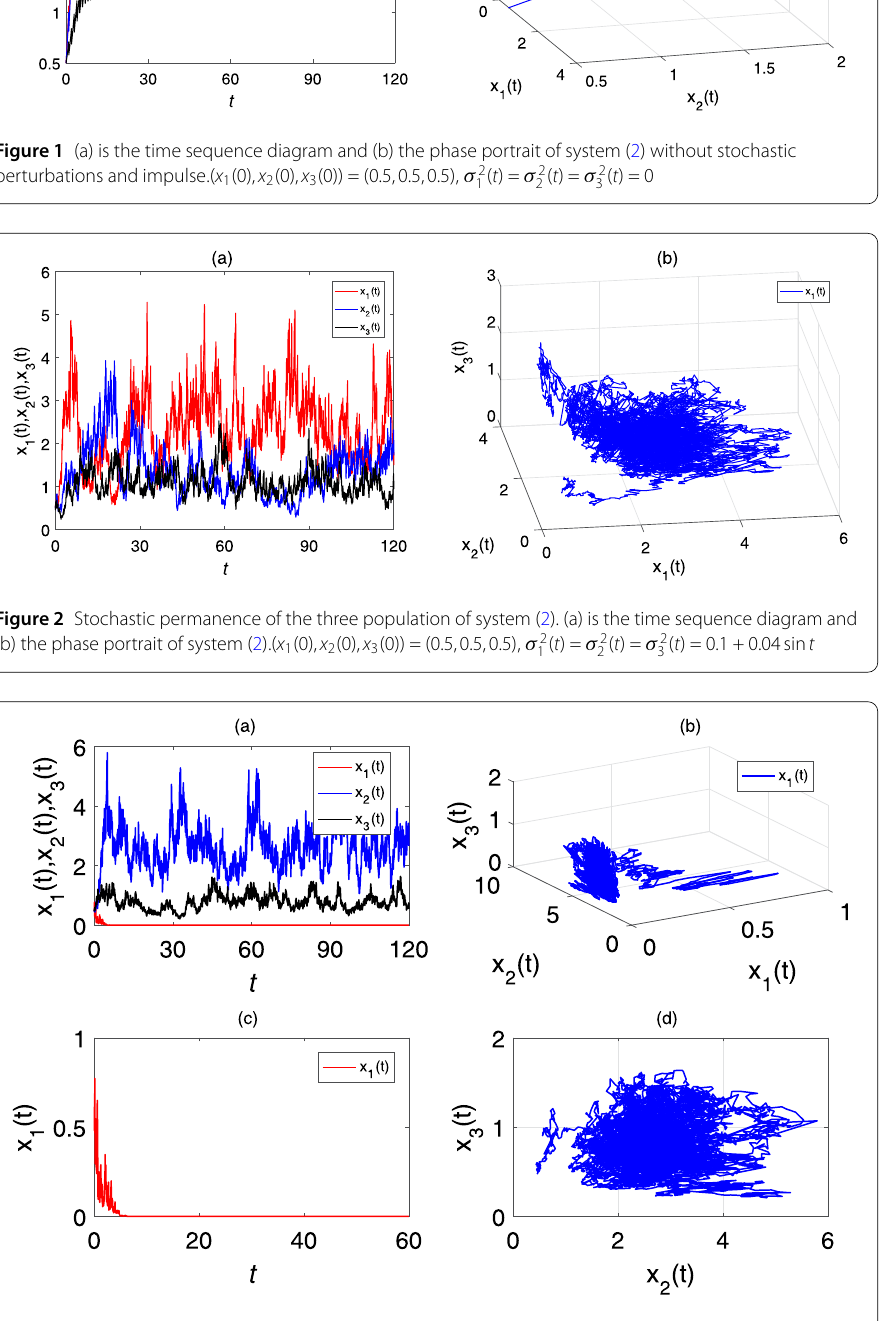
Figure 3 Extinction of the prey population x 1 ( t ) of system (2). (a) Time sequence diagram and (b) the phase portrait of system (2).( x 1 (0), x 2 (0), x 3 (0)) = (0.5,0.5,0.5), σ 2 2 ( t ) = σ 2 3 ( t ) = 0.1 + 0.04sin t , σ 2 1 ( t ) = 2.56 + 0.04sin